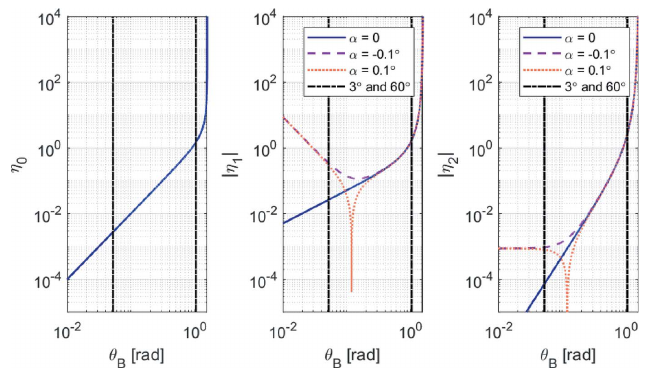
Figure 3 Trigonometric functions related to the variation of: the Bragg angle (cid:2) B with respect to energy E , as (cid:7) 0 ; and the gap g with respect to (cid:2) B and E , as (cid:7) 1 and (cid:7) 2 (shown in absolute values for readability in the logarithmic scale), respectively. They follow (11), (12) and (13) for the DCM geometry of Fig. 1, including representative miscut manufacturing limitations, i.e. crystals with small asymmetric cut angles (cid:5) . The HD- DCM angular limits are represented by the vertical dash-dotted lines at 3 (cid:5) and 60 (cid:5)